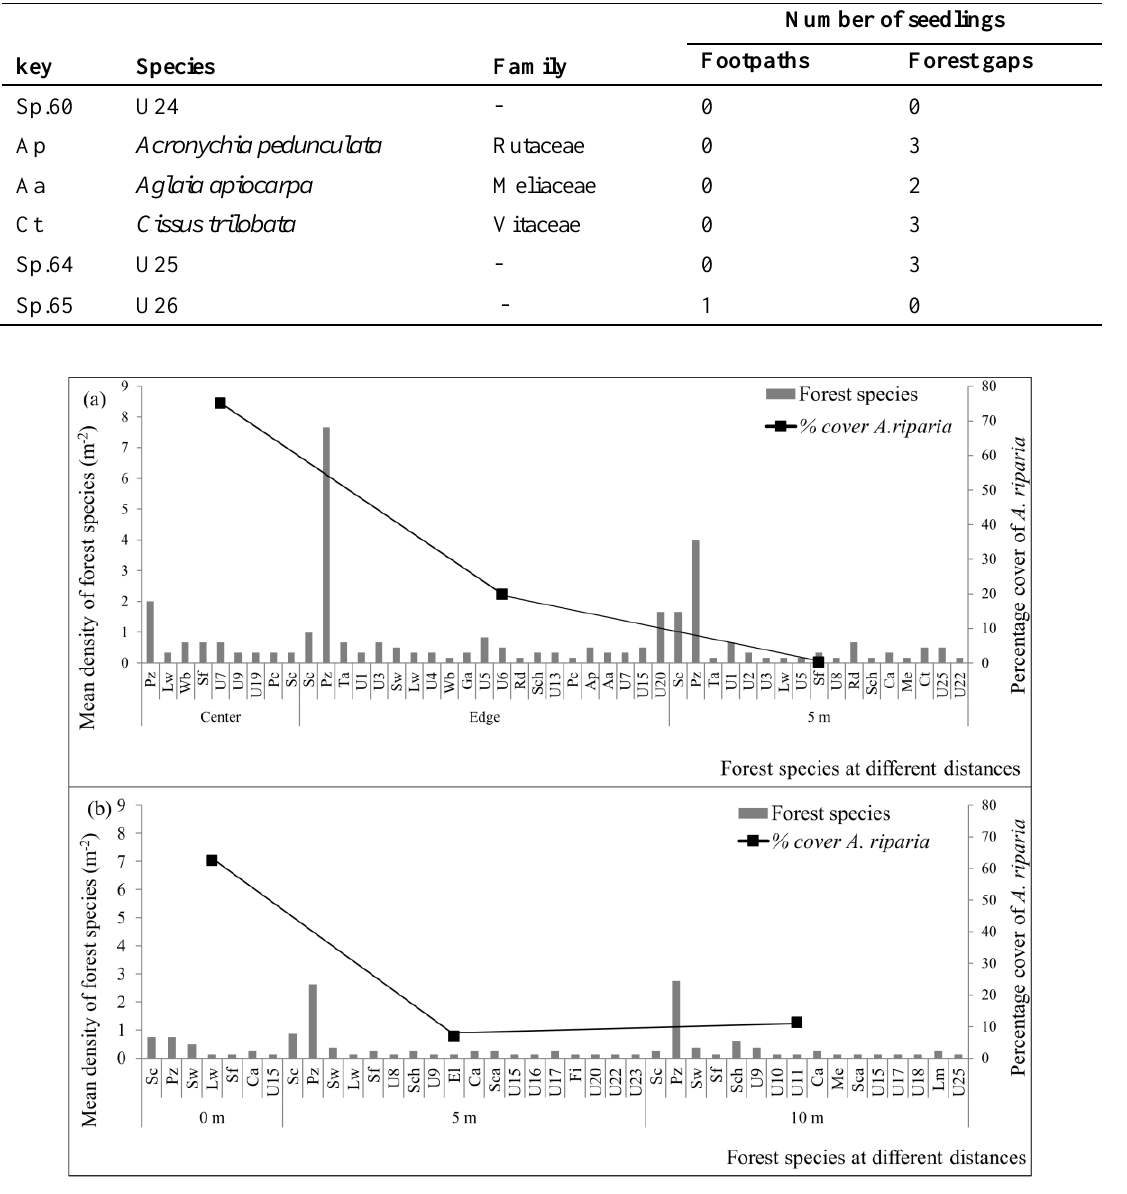
Figure 4: (a) The graph of the mean density of forest species and the percentage cover of A. riparia vs the distance from the forest gaps (b) The graph of the mean density of forest species and the percentage cover of A. ripria vs the distance from the